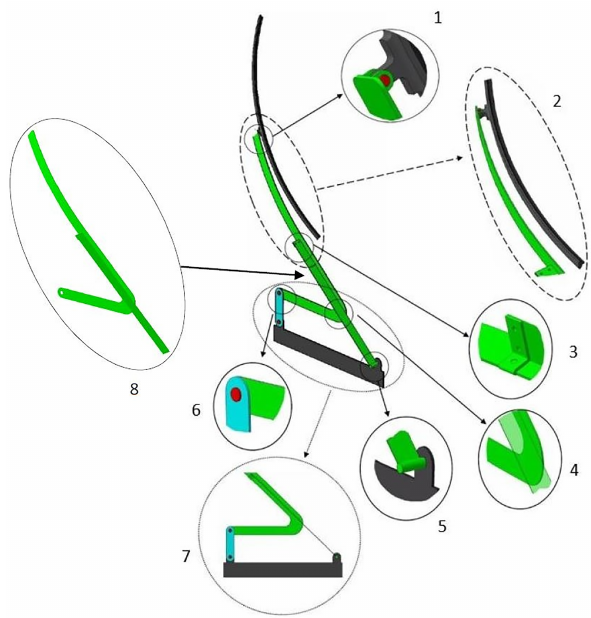
Figure 1. Compliant wiper mechanism.